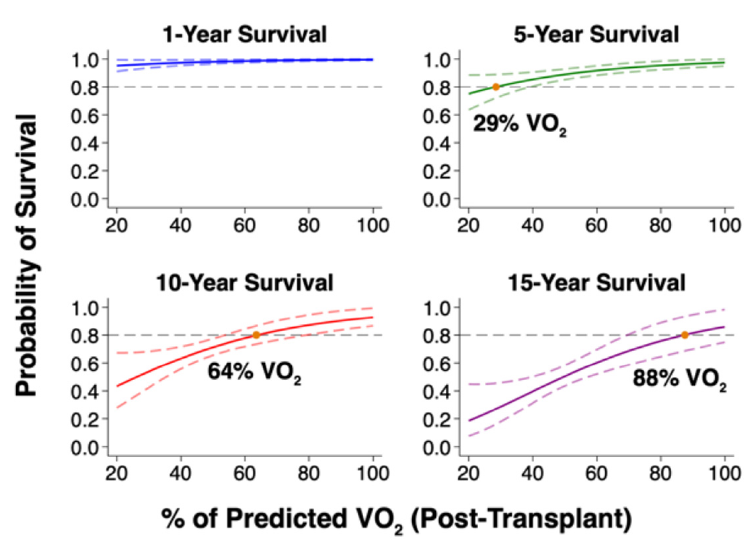
Figure 4. Predicted Survival Free from Re-transplantation based on Post-Transplant % Predicted Peak V O 2 . Post-Transplant % Predicted Peak V O 2 predicts long-term survival. Plots based on unadjusted flexible parametric survival models, displaying mean survival (solid lines) along with upper and lower 95% confidence intervals (dashed lines). Acronyms: V O 2 , oxygen consumption.